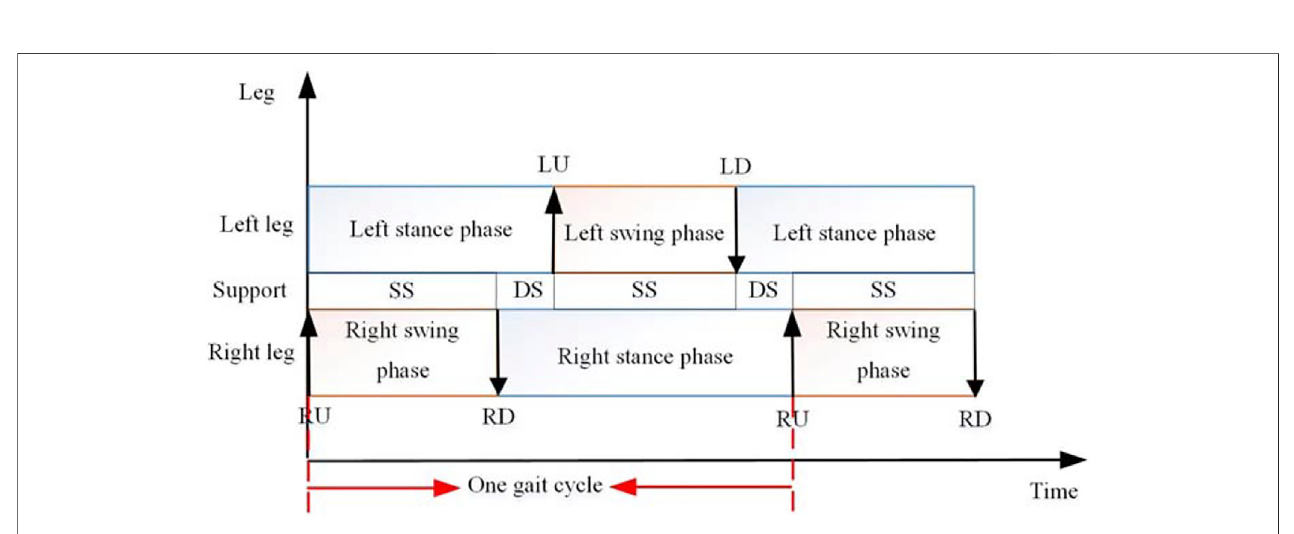
FIGURE 11 | Bipedal locomotion stride for Amphioctopus marginatus Octopus